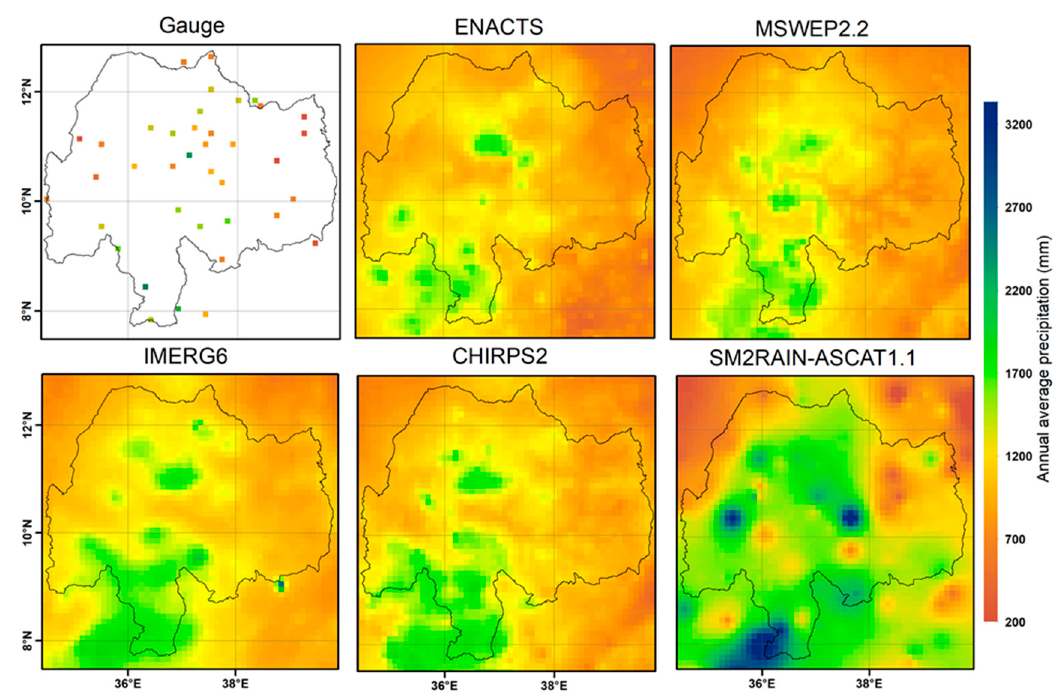
Figure 2. Mean annual precipitation generated from different datasets over UBNRB. Terrain elevation and orientation highly affect the characteristics of precipitation distributions.